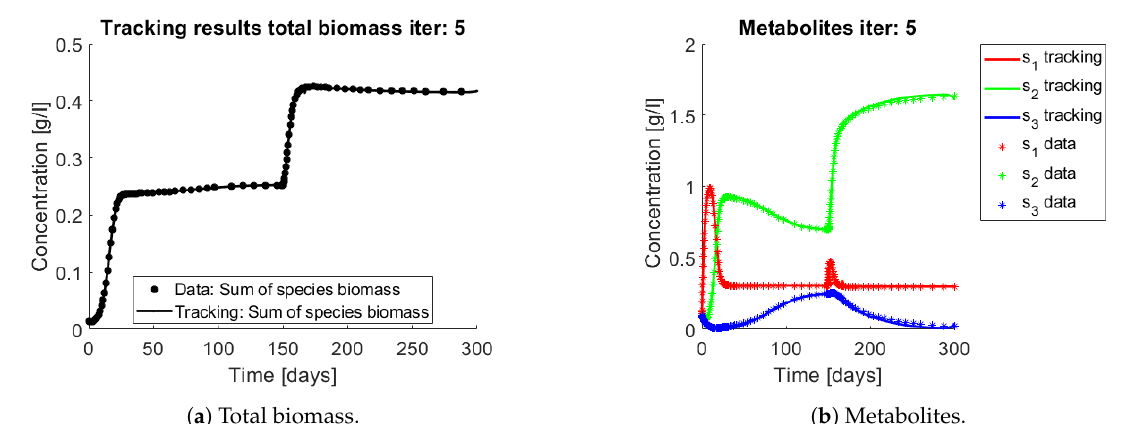
Figure 6. Asterisks represent the synthetic data, while the continuous lines represent the method’s output. The method is able to reconstruct the metabolites pattern, from the biomasses concentrations.